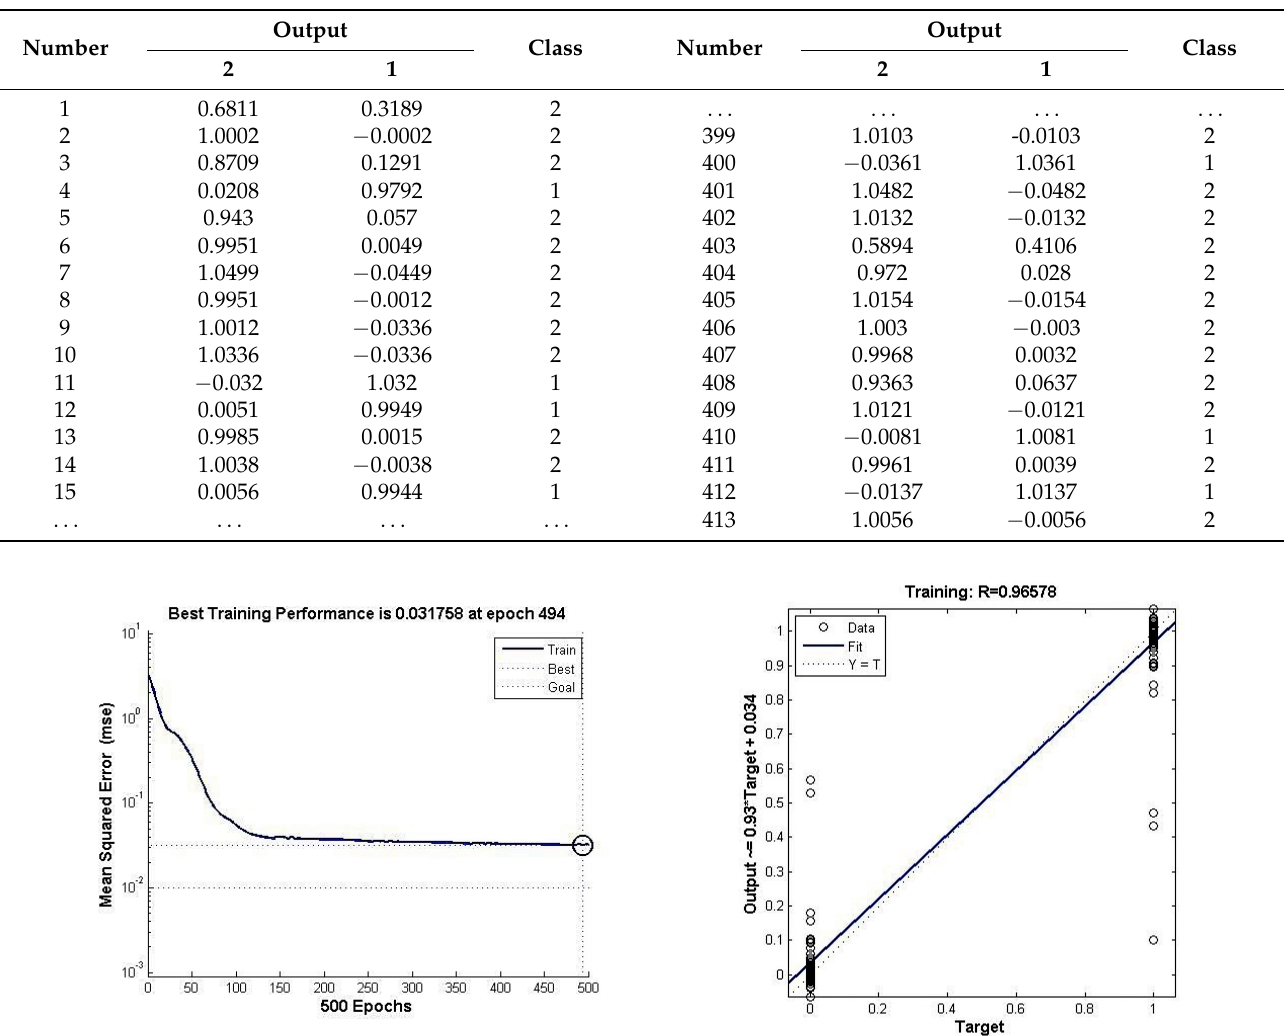
Table 1. Identification results of test set data.